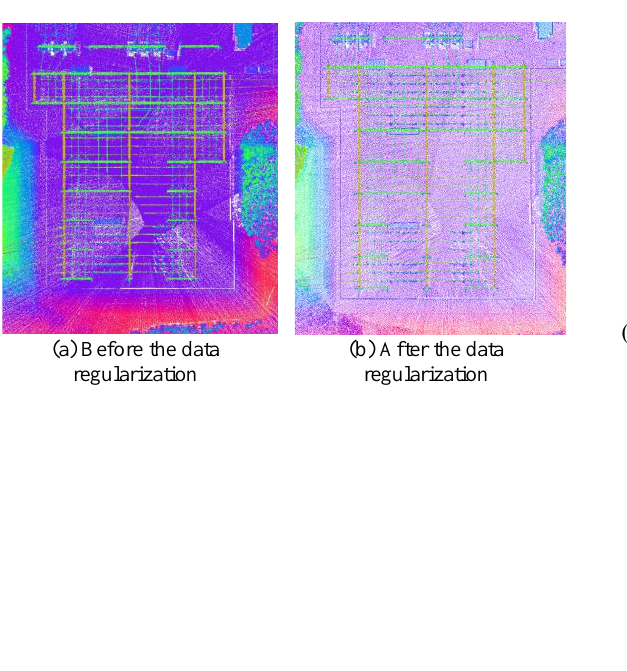
Figure 2. Overview and detailed snapshot of the data Figure 3 shows the overall and details snapshot of the point clouds before and after regularization. The point clouds are rendered with height, and the green represents the higher height. Through the regularized point cloud details, as shown in Figure 3 (c) (d), it can be speculated that after voxel regularization, the phenomenon of uneven point density and uneven scanning line spacing in the original point cloud has been eliminated. It avoids the influence of uneven point density and spacing, reducing the robustness of subsequent equipment extraction.